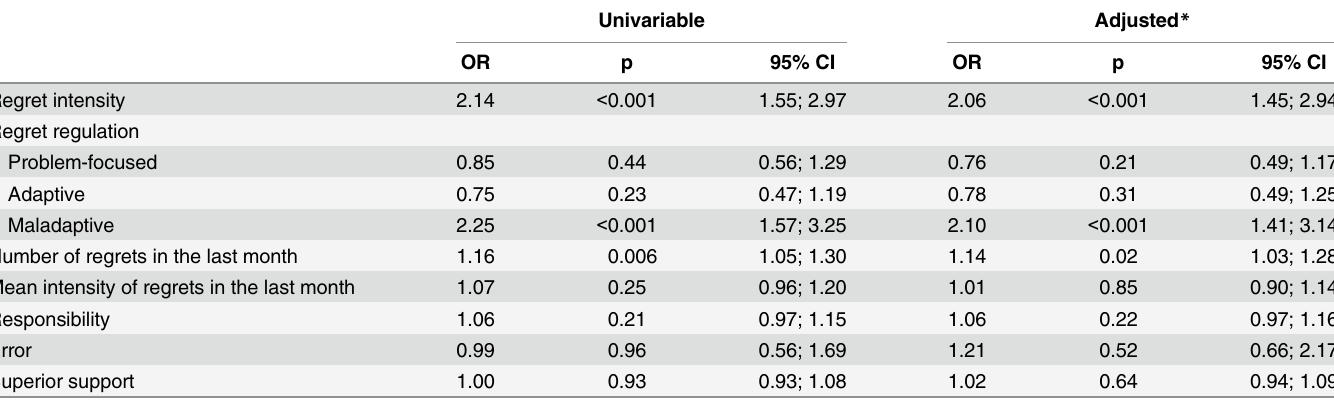
Table 3. Odds Ratios and 95% Confidence Intervals from Logistic Regression Models to Evaluate the Association Between Measures of Regret and Sleeping Pill